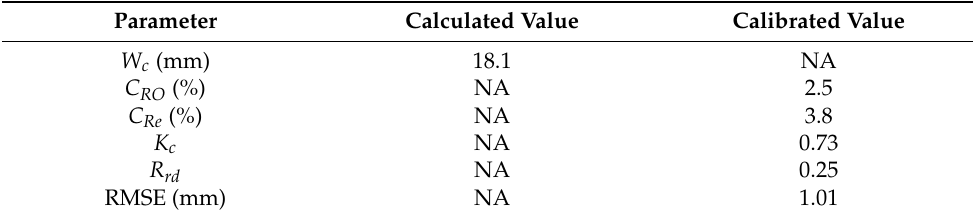
Table A3. Water budget from calibration simulation, 2015–2018.